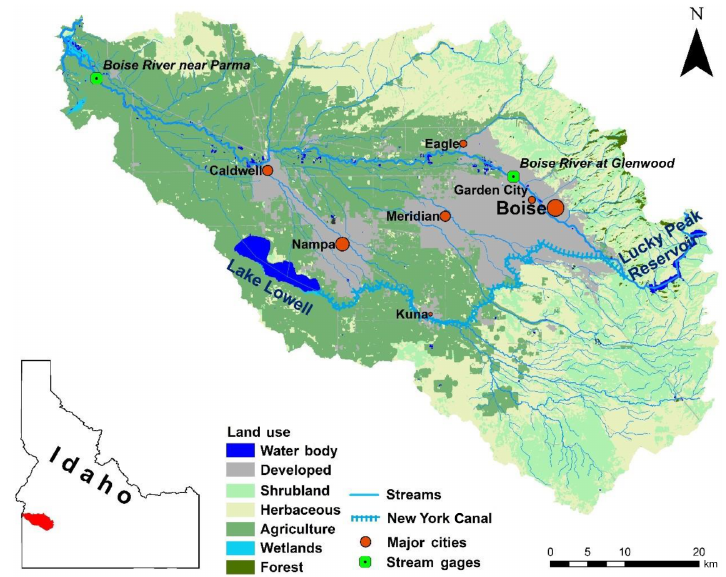
Figure 1. Study area: the Treasure Valley.